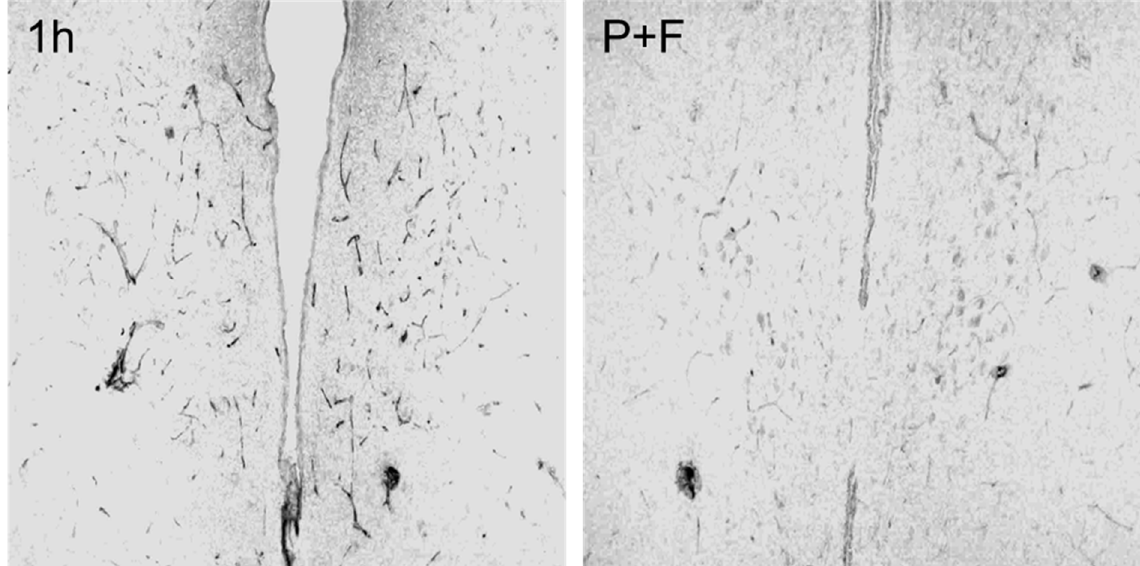
Figure A12. Estrogen-receptor immunoreactivity in the paraventricular nuclei of Syrian hamsters. Comparison between 1 h manual sleep deprivation (1 h, group 3a) and sexual stimulation with pheromone and females (P+F, group 1). Magnification: 50×.